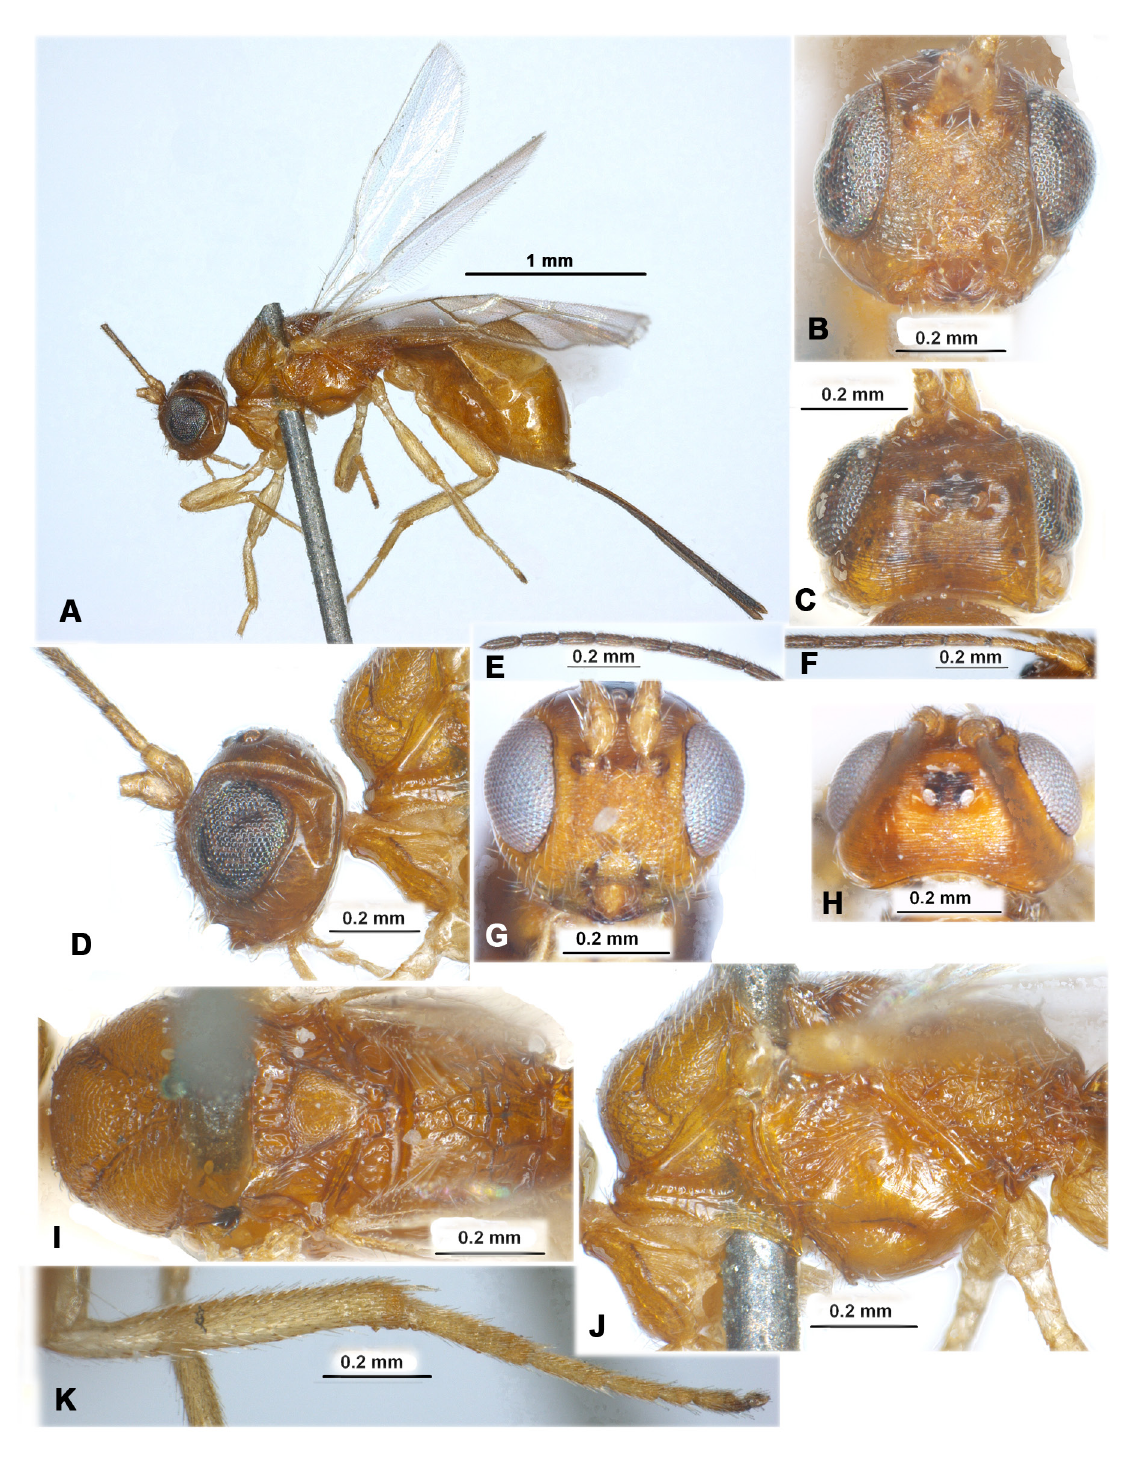
Fig. 34. Parallorhogas testaceus (Szépligeti, 1914). A–F, I–K . Holotype, ♀ (MNBG). G–H . Arabian specimen (RMNH). A . Habitus, lateral view. B, G . Head, front view. C, H . Head, dorsal view. D . Head, lateral view. E . Apical segments of antenna. F . Basal segments of antenna. I . Mesosoma, dorsal view. J . Mesosoma, lateral view. K . Hind tibia and